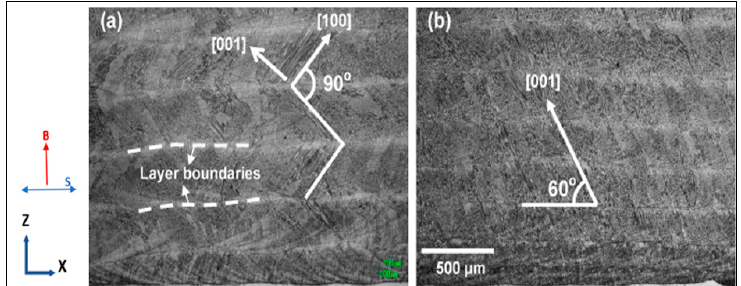
Figure 5. Longitudinal (X-Z) section of DLD IN625. ( a ) Bidirectional scan, ( b ) unidirectional scan, B-Build direction, and S-Laser scan direction (adapted with permission from Ref. [34] 2009, Elsevier).